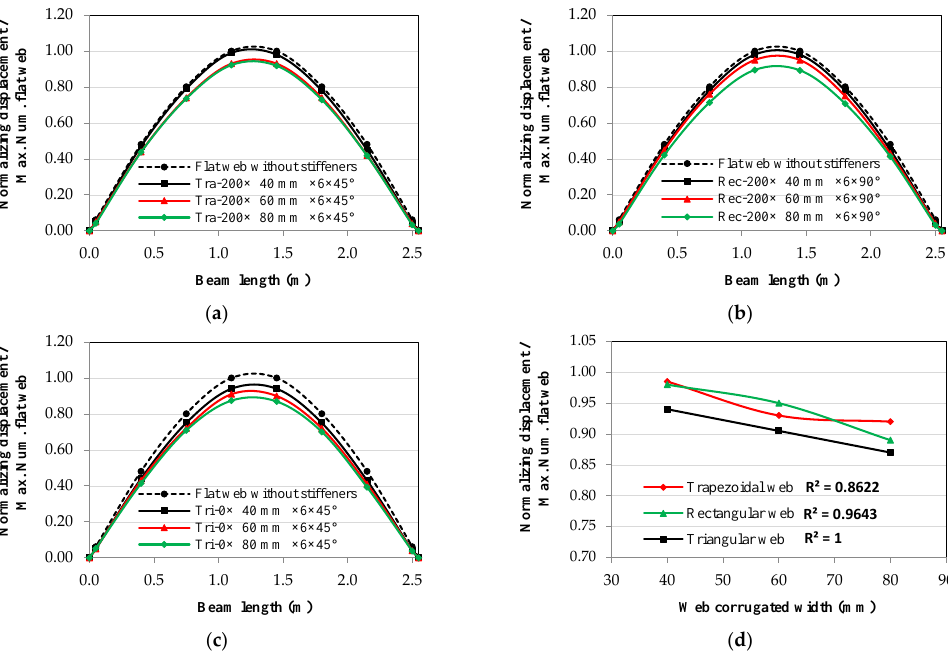
Figure 12. Corrugated width effect on the relationship between normalized displacement and beam length for the 1st mode shape: ( a ) trapezoidal web, ( b ) rectangular web, ( c ) triangular web, and ( d ) width effect at the 1st mode shape.